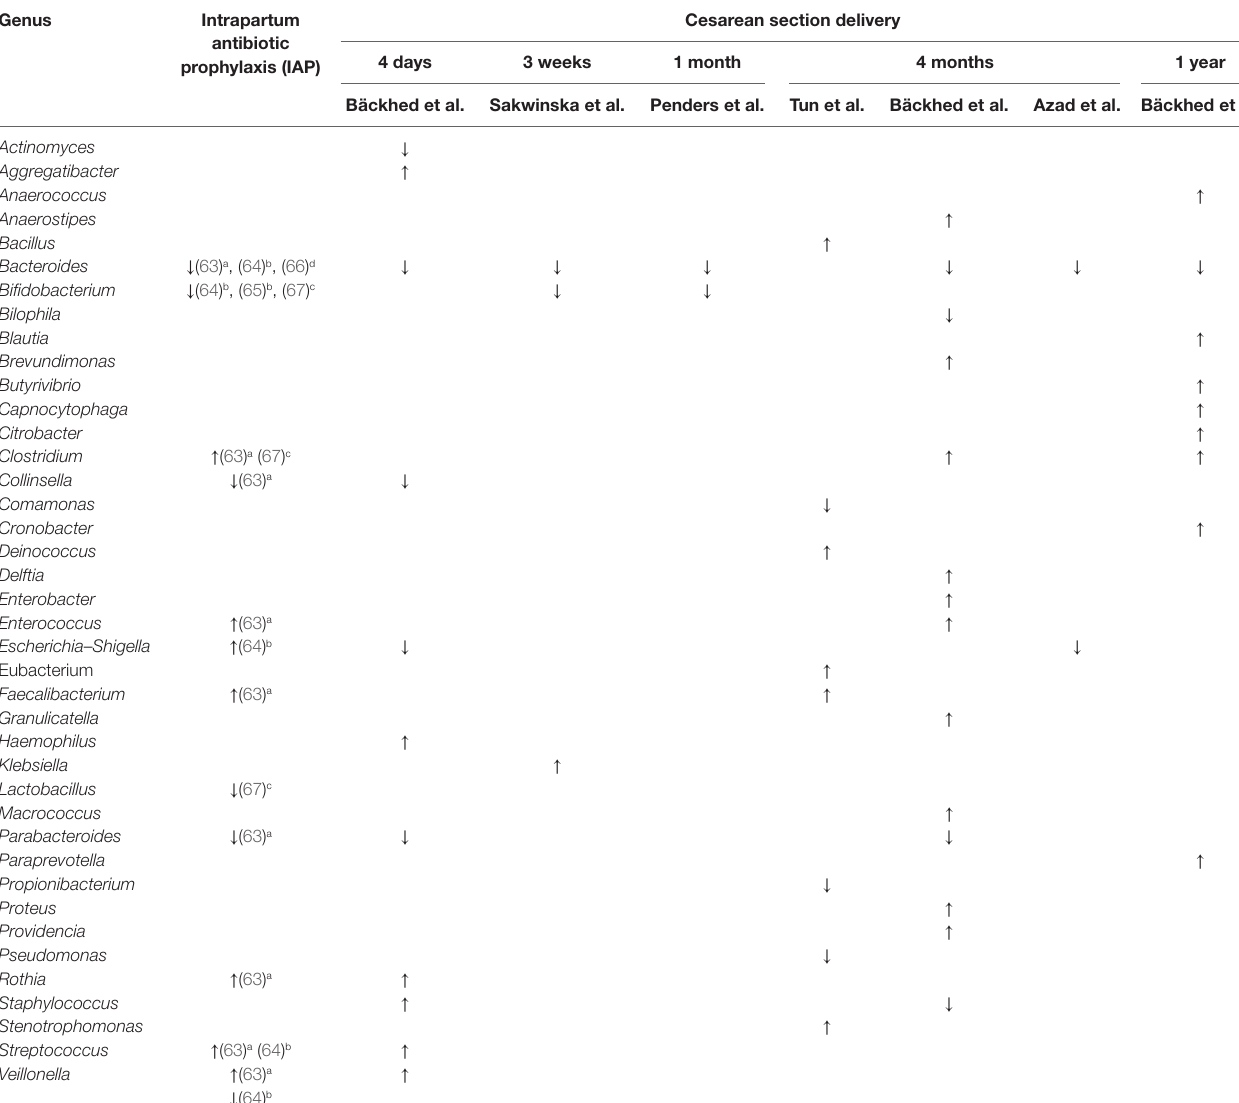
TABLe 2 | Genera of bacteria reported to be differentially abundant in [Bäckhed et al. (51), Sakwinska et al. (49), Penders et al. (52), Tun et al. (68), and Azad et al. (50)] cesarean section delivered (CSD) infants compared to vaginally delivered (VD) infants across five studies.